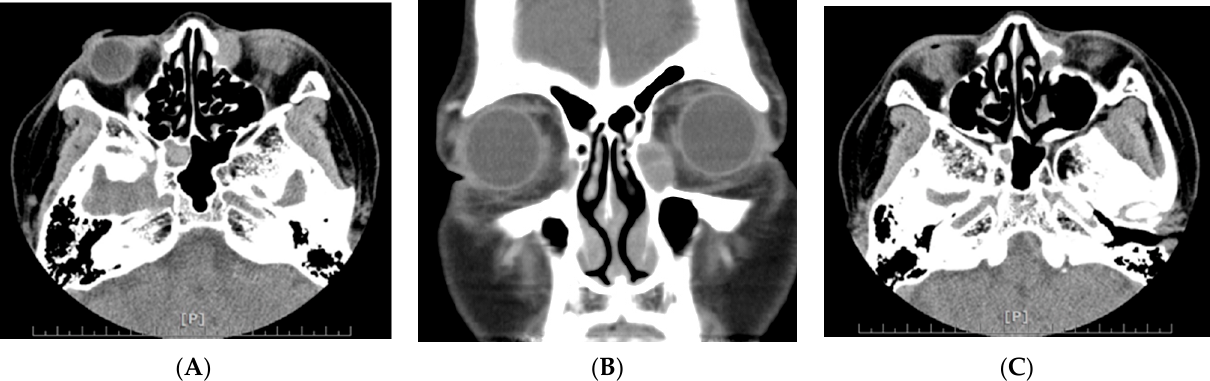
Figure 2. Orbital computed tomography of lacrimal sac melanoma. ( A , B ) A 14 mm ovoid shape soft tissue mass in left lacrimal fossa. ( C ) Lacrimal sac tumor with involvement of nasolacrimal duct.